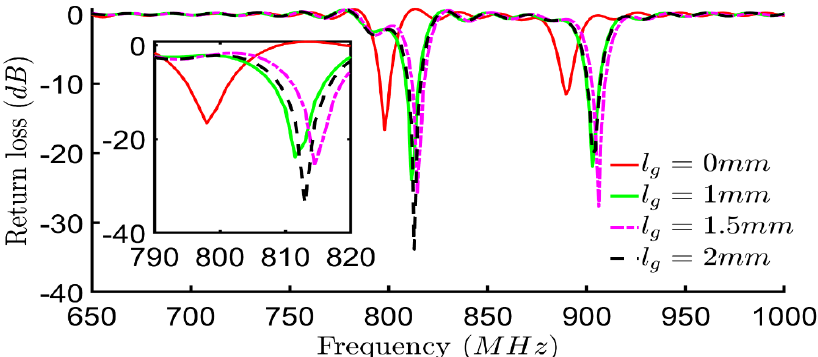
Figure 9. The return loss of the proposed structure vs. different gap lengths lg without stubs.